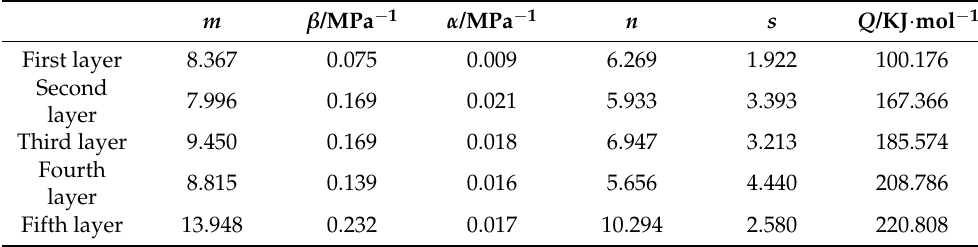
Table 4. Parameters and activation energy in each layer of the